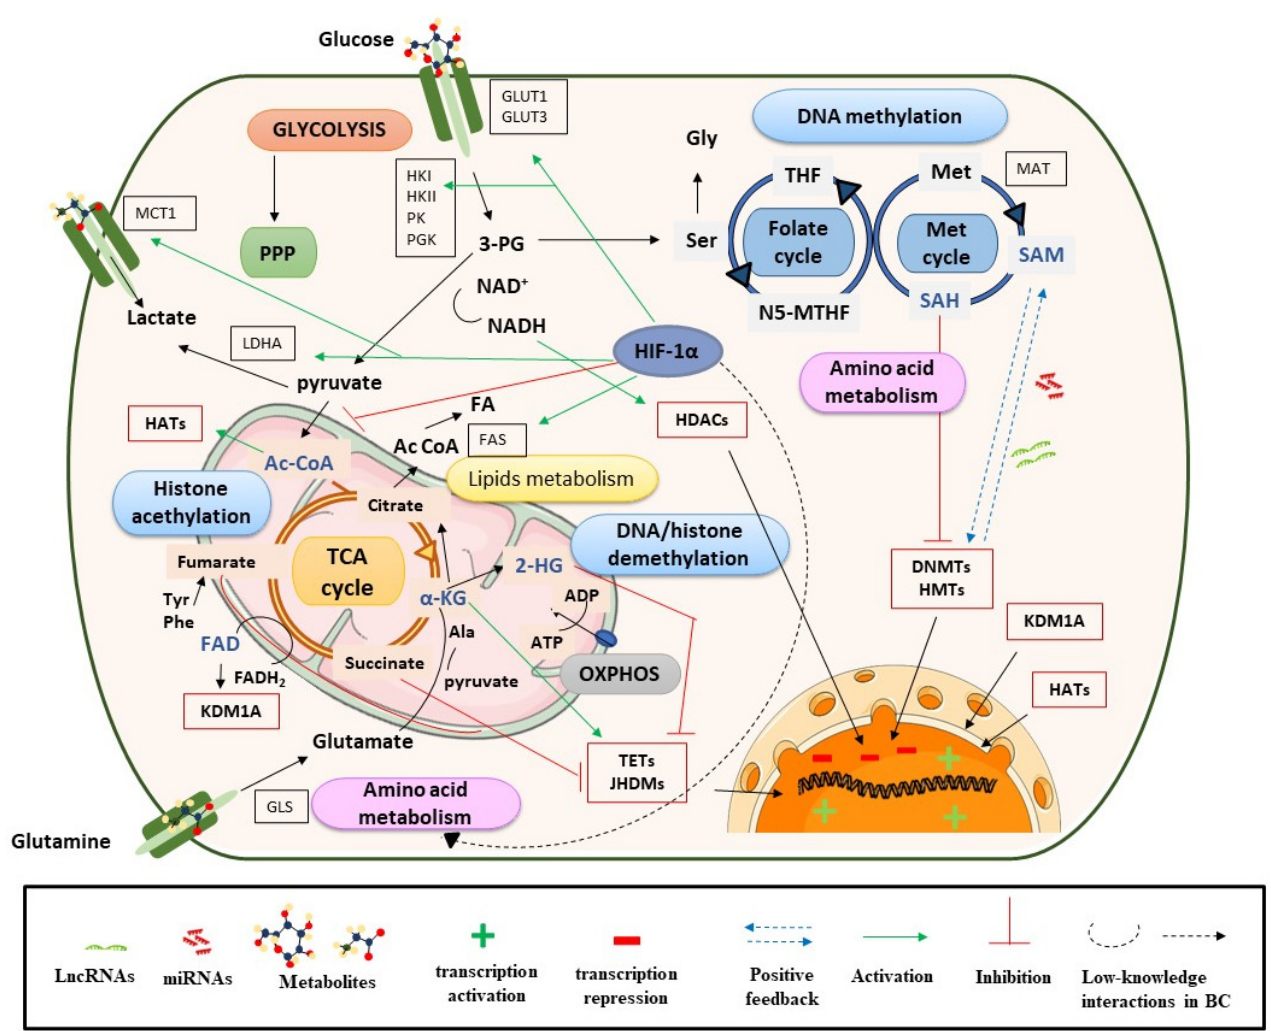
Figure 1. Metabolism controls epigenetic enzymes in BC. Ac CoA: acetyl coenzyme A; ADP: adenosine diphosphate; α -